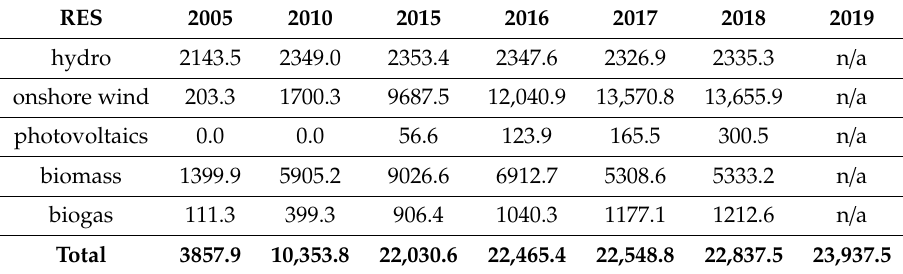
Table 9. Electricity generation from renewable energy sources in Poland in 2005–2019, in (GWh) [40].